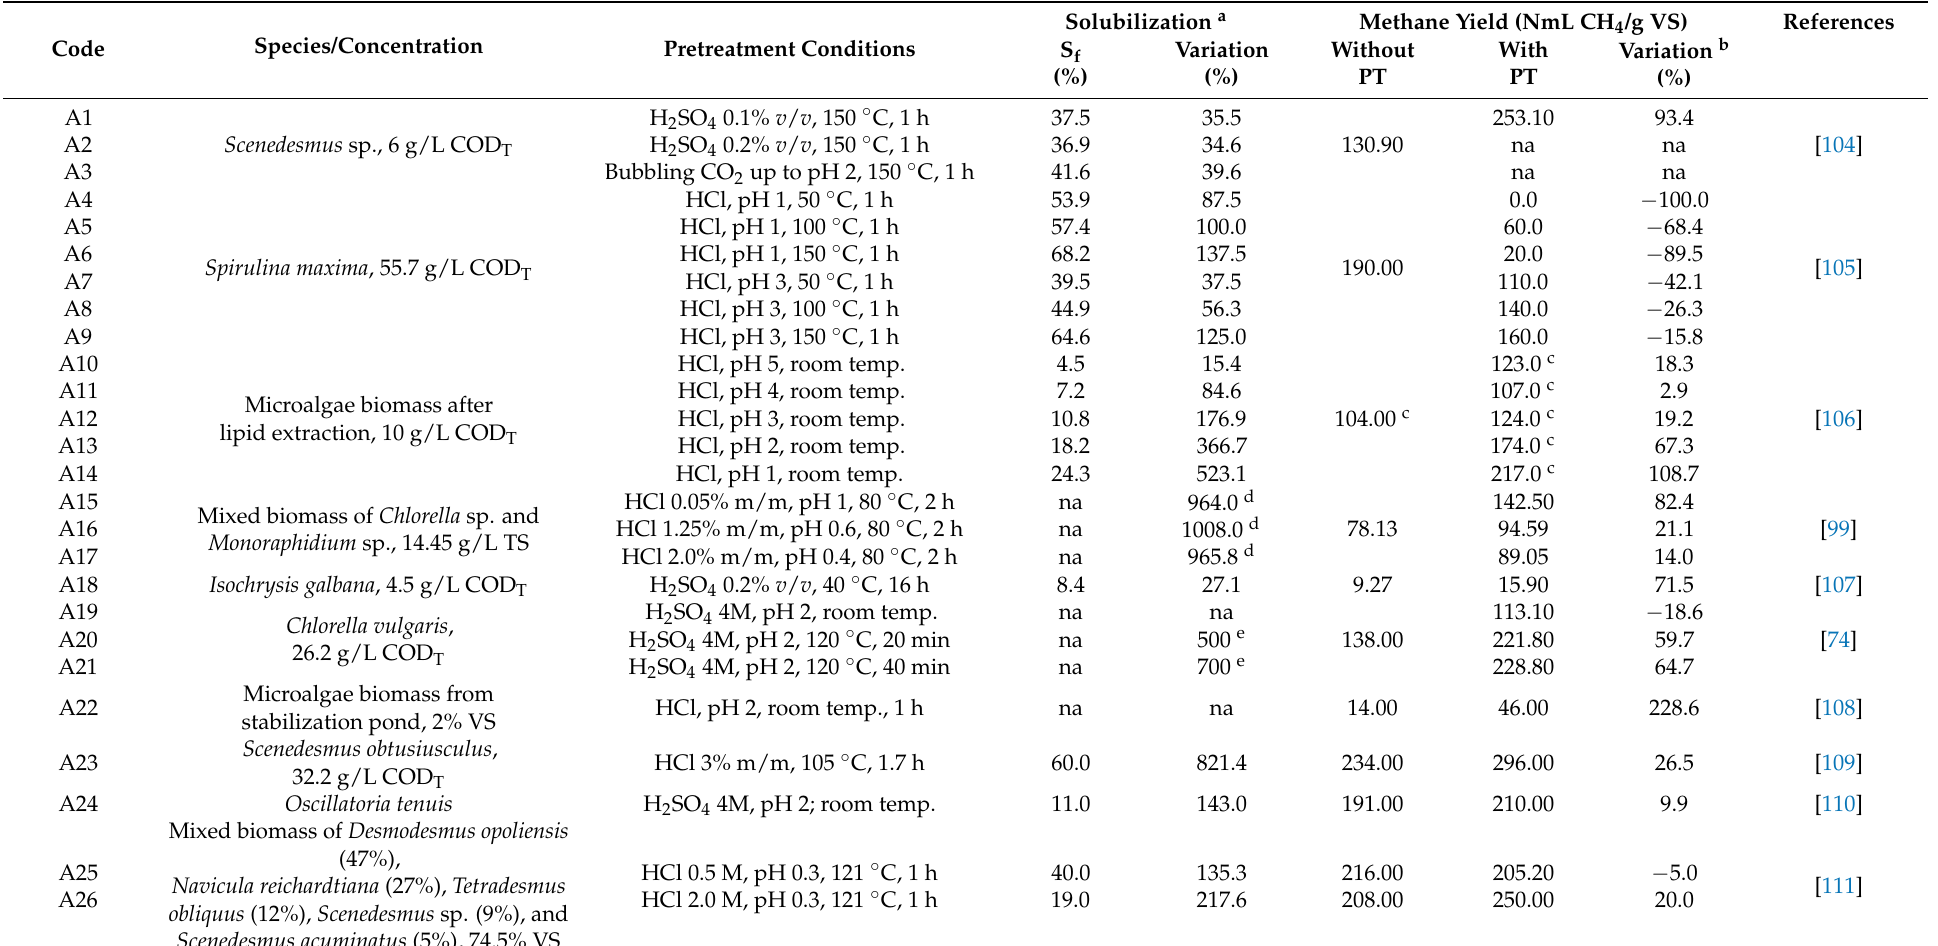
Table 4. Chemical and thermochemical pretreatments of algal biomass for methane